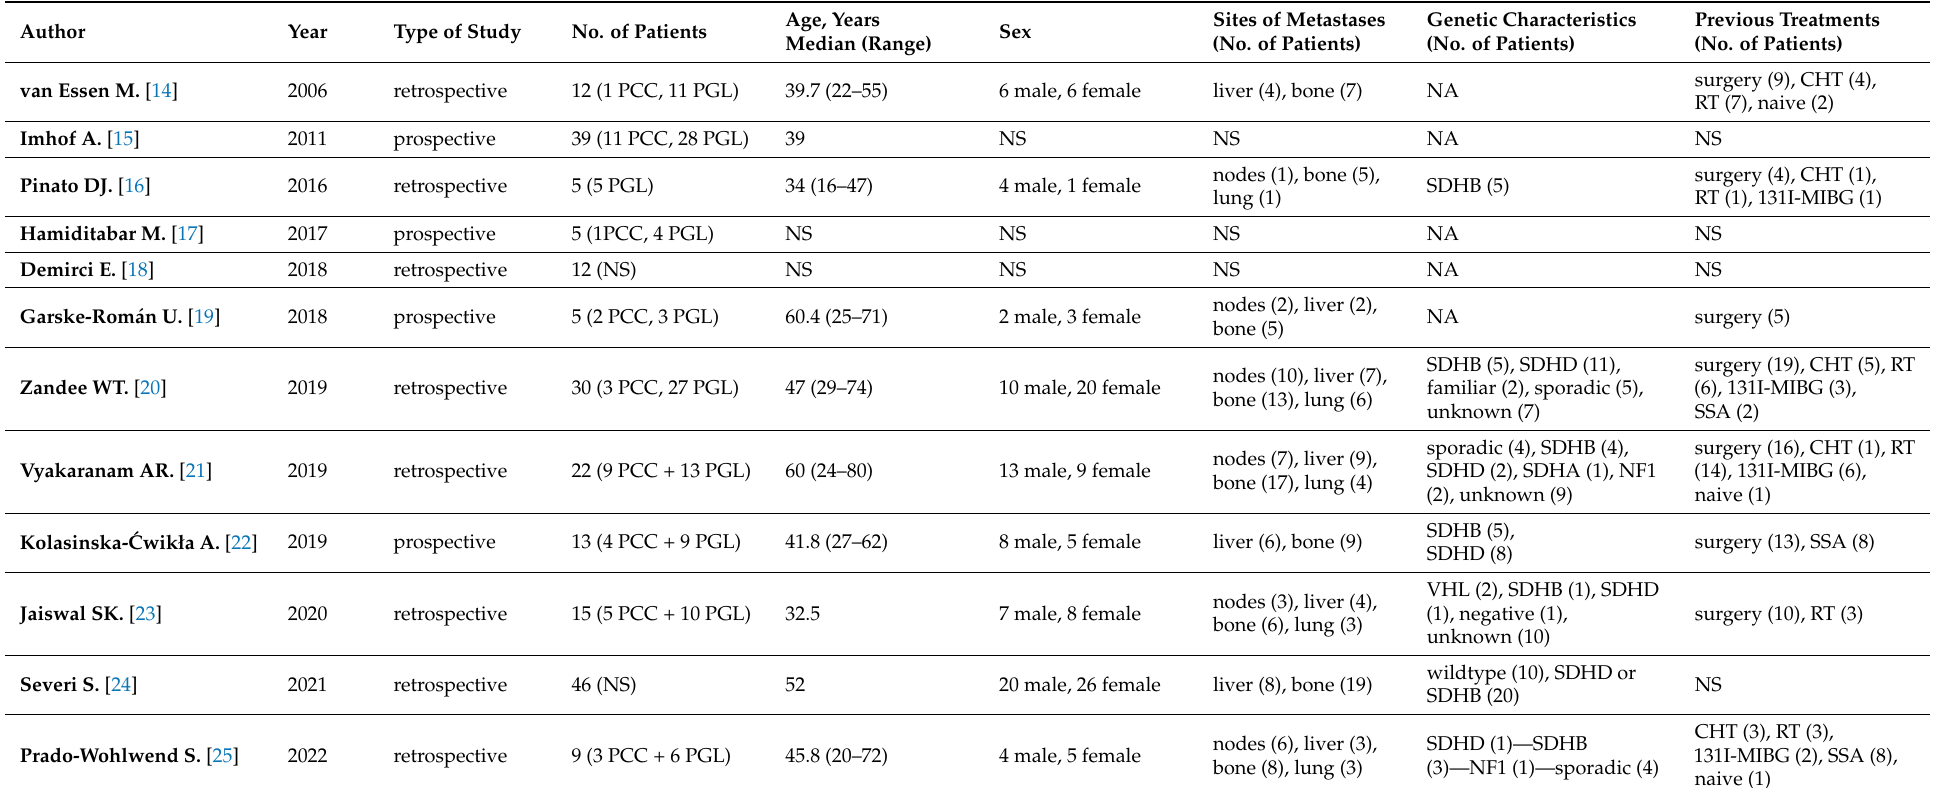
Table 1. Baseline characteristics of included